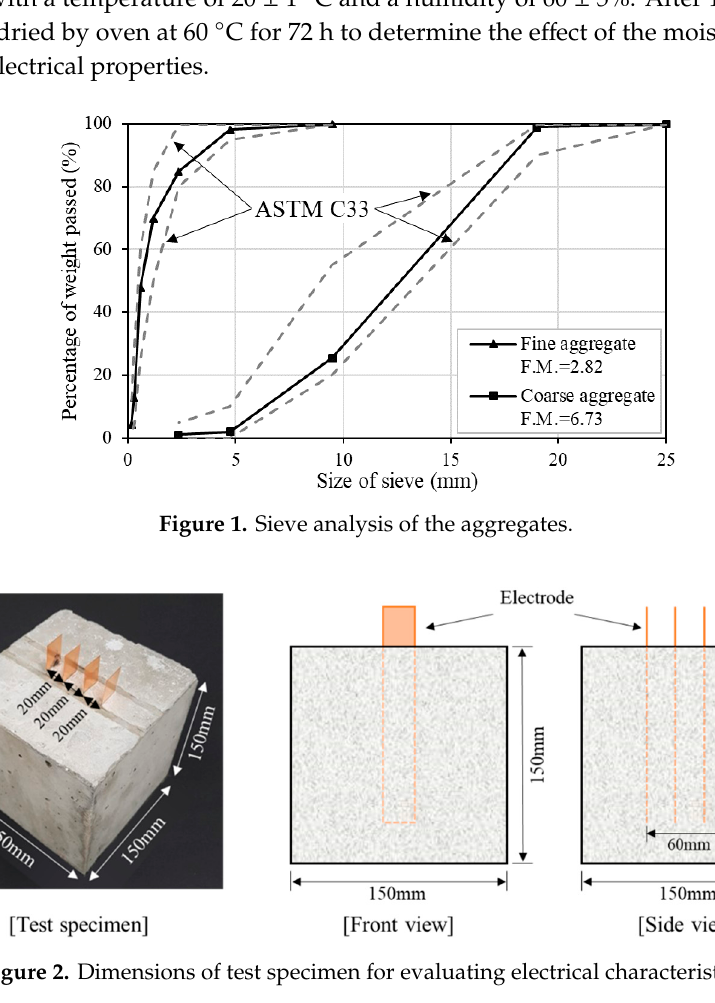
Figure 2. Dimensions of test specimen for evaluating electrical characteristics.